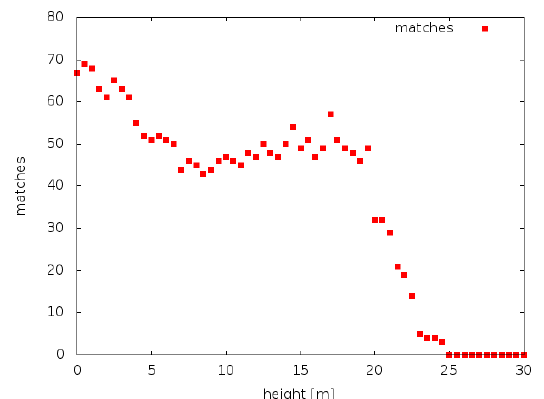
Figure 4: Matches between reference and reconstructed trees in relation to height above